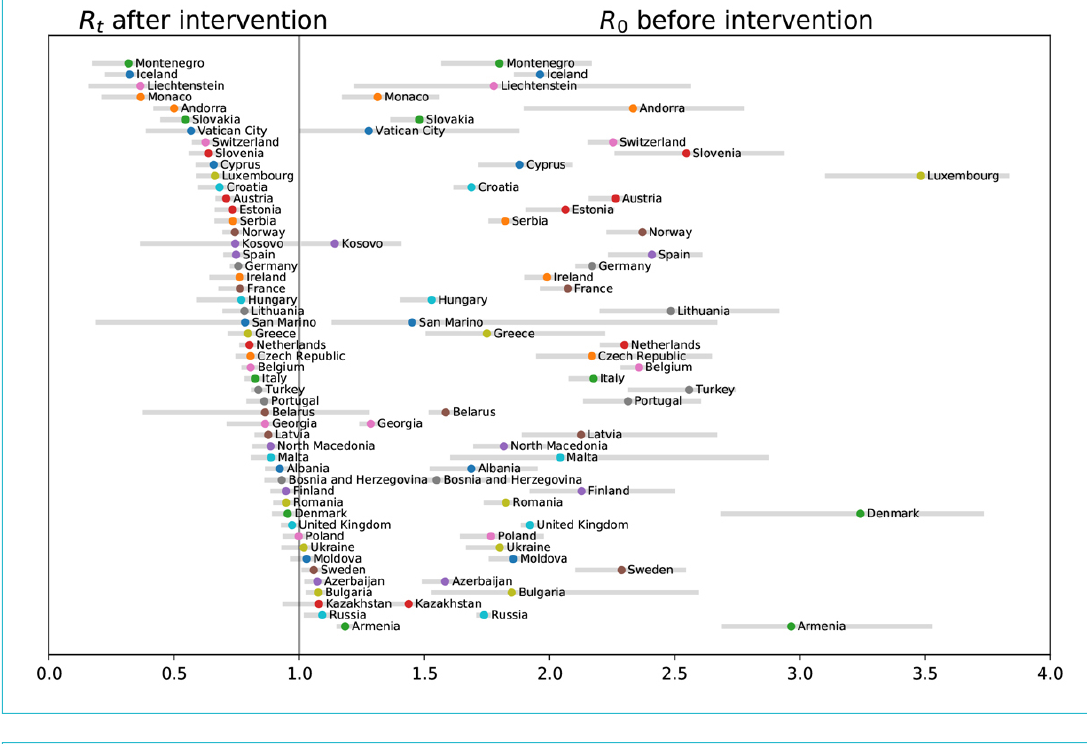
Figure 5: Inferred reproduction number R t . Mean values (circles) and 90% confidence intervals (gray shades). The countries are ordered by the value of R t after interventions.